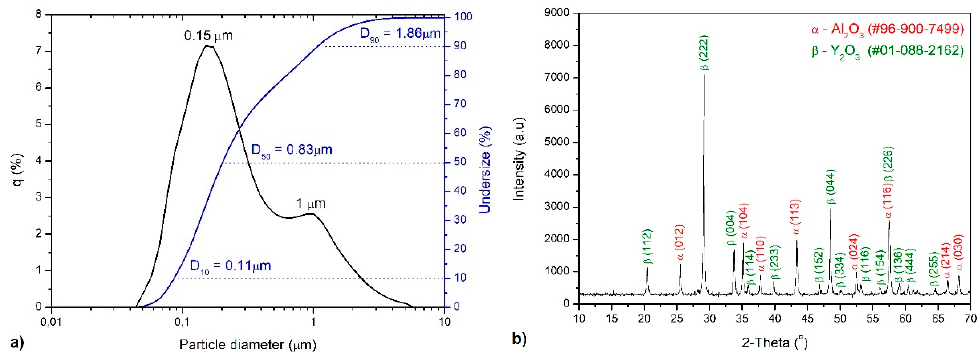
Figure 3. Characterization of the powder’s mixture: ( a ) particle size distribution; ( b ) XRD patterns.